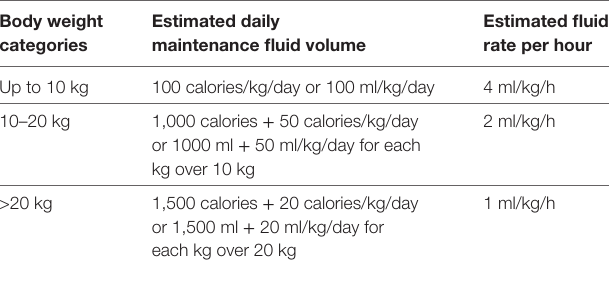
TABLe 6 | Holliday and Segar estimation of maintenance fluid